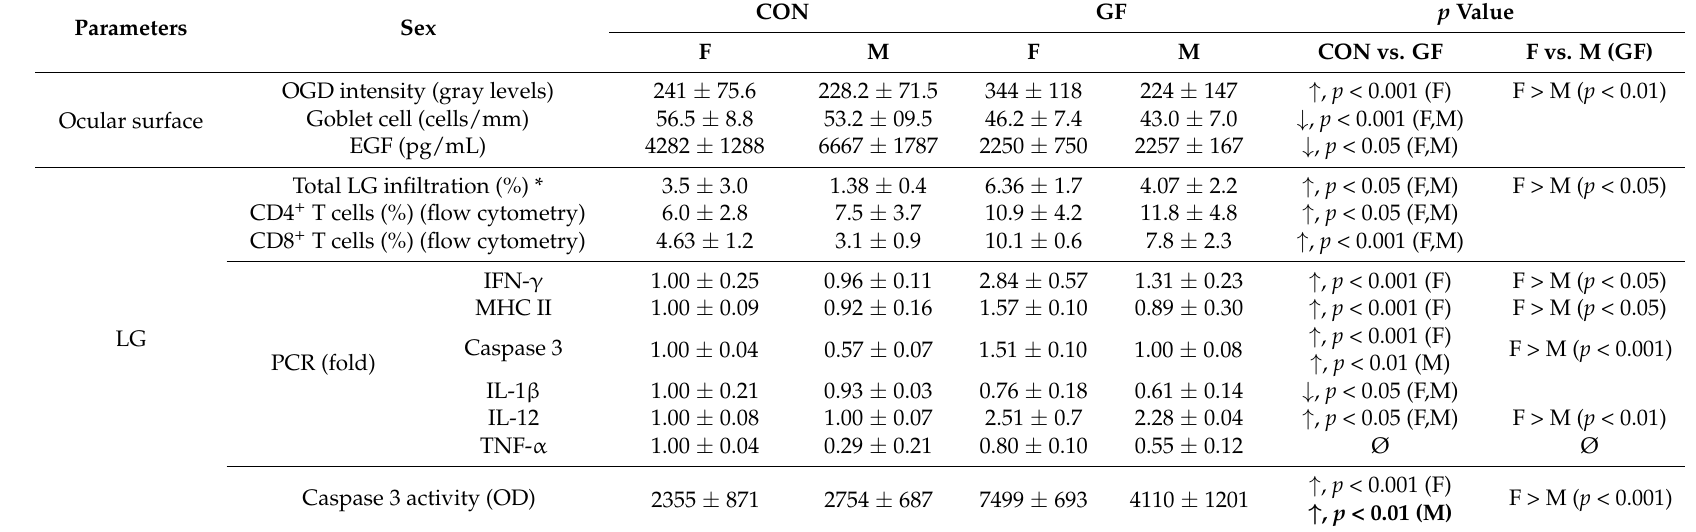
Table 1. Summary of Findings in Ocular Surface and Lacrimal Gland within mice raised in conventional vivarium (CONV) or in germ-free (GF) conditions.